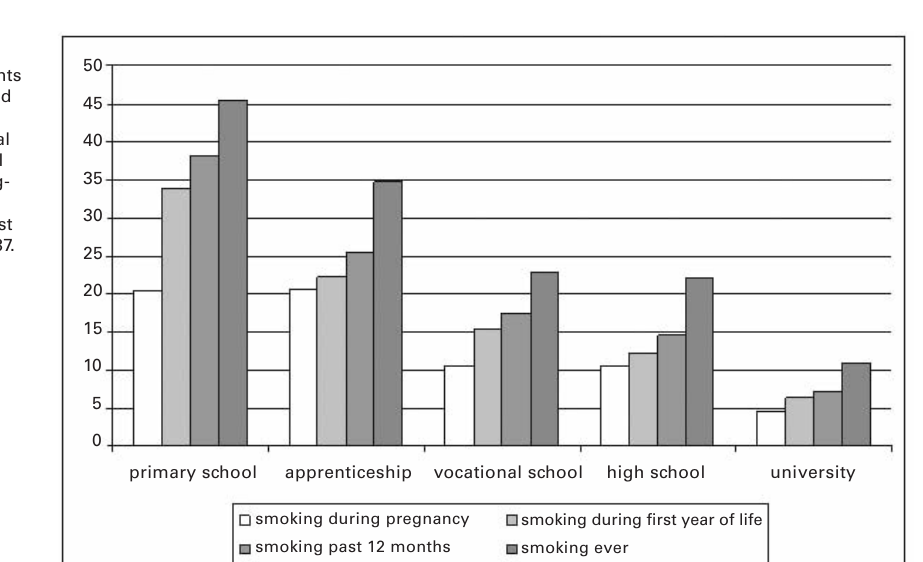
Percentage of parents smoking with regard to the highest parental educational level during several periods of life